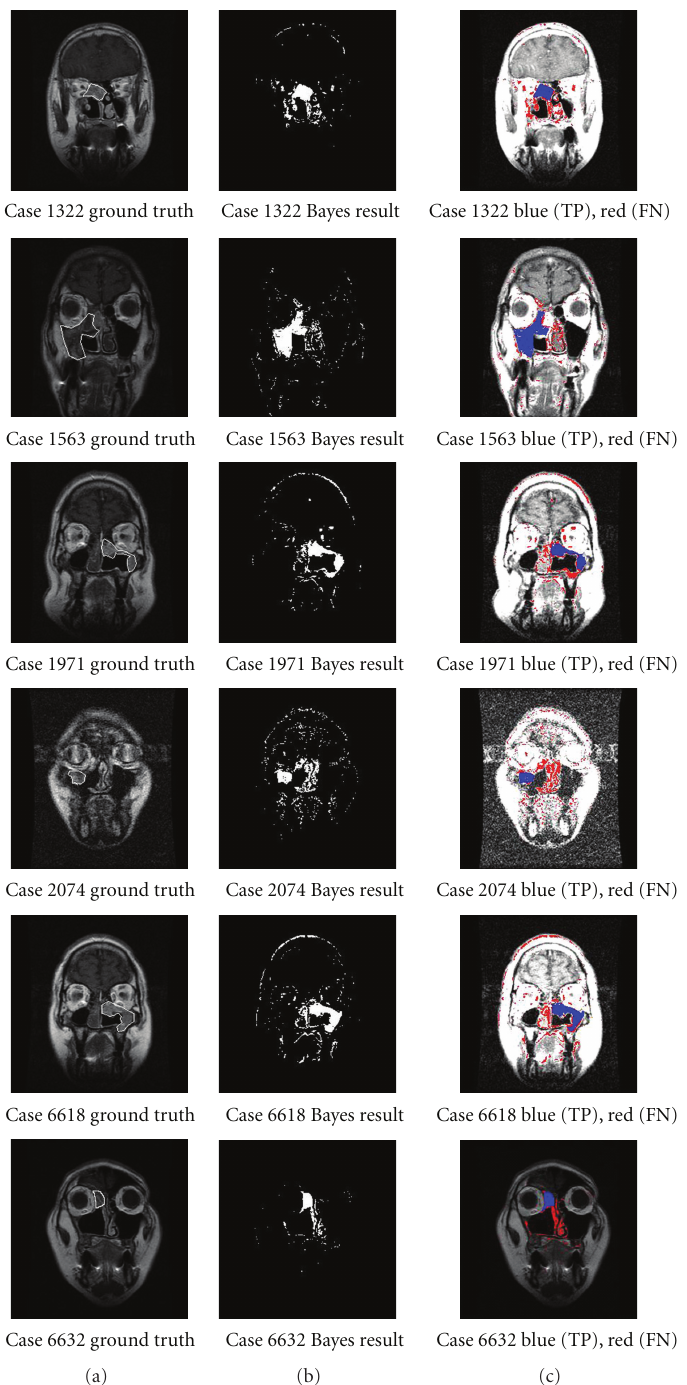
Figure 4: Bayes-Gaussian detection results. (a) Ground truth; (b) detection result shown by color white; (c) color blue is for true positive and color red is for false